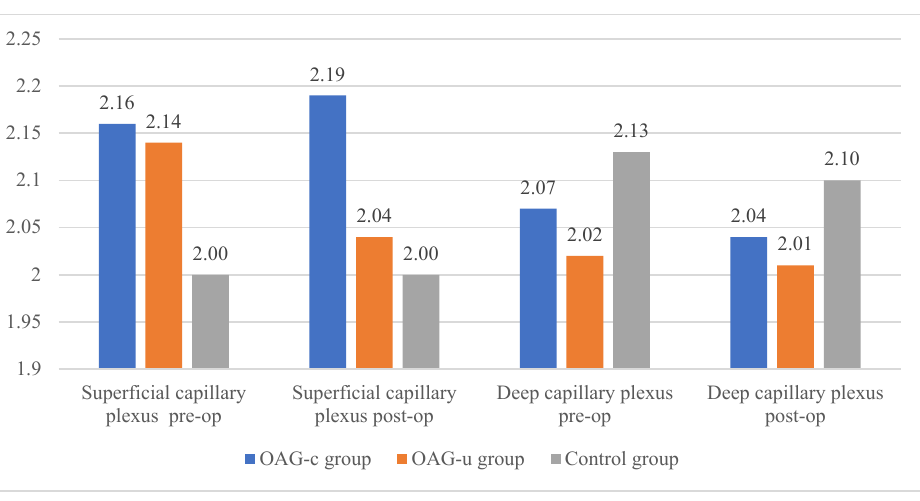
Figure 10. FAZ perimeter of superficial and deep capillary layers before and 6 months after cataract surgery. Vertical axis shows FAZ perimeter (mm).